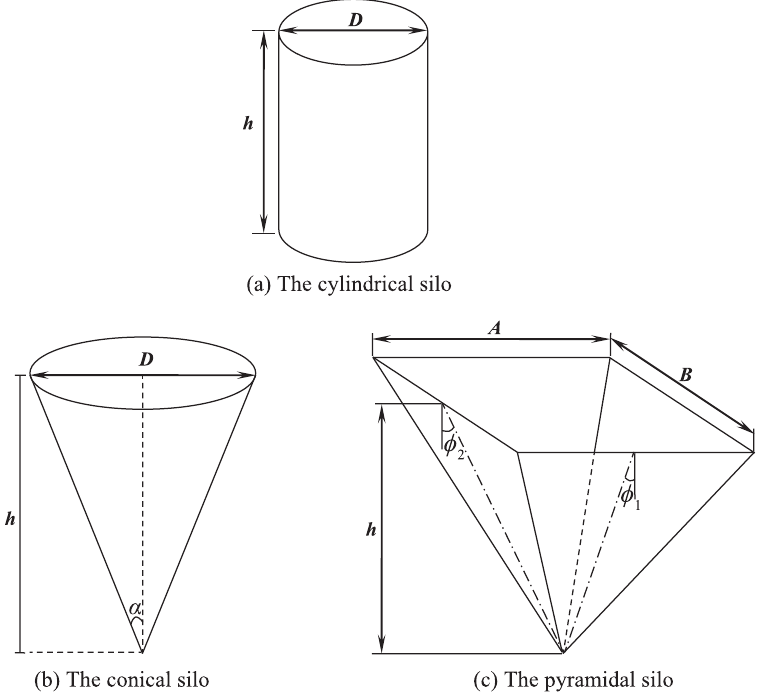
Fig. 1 The diagram of deep silo and shallow